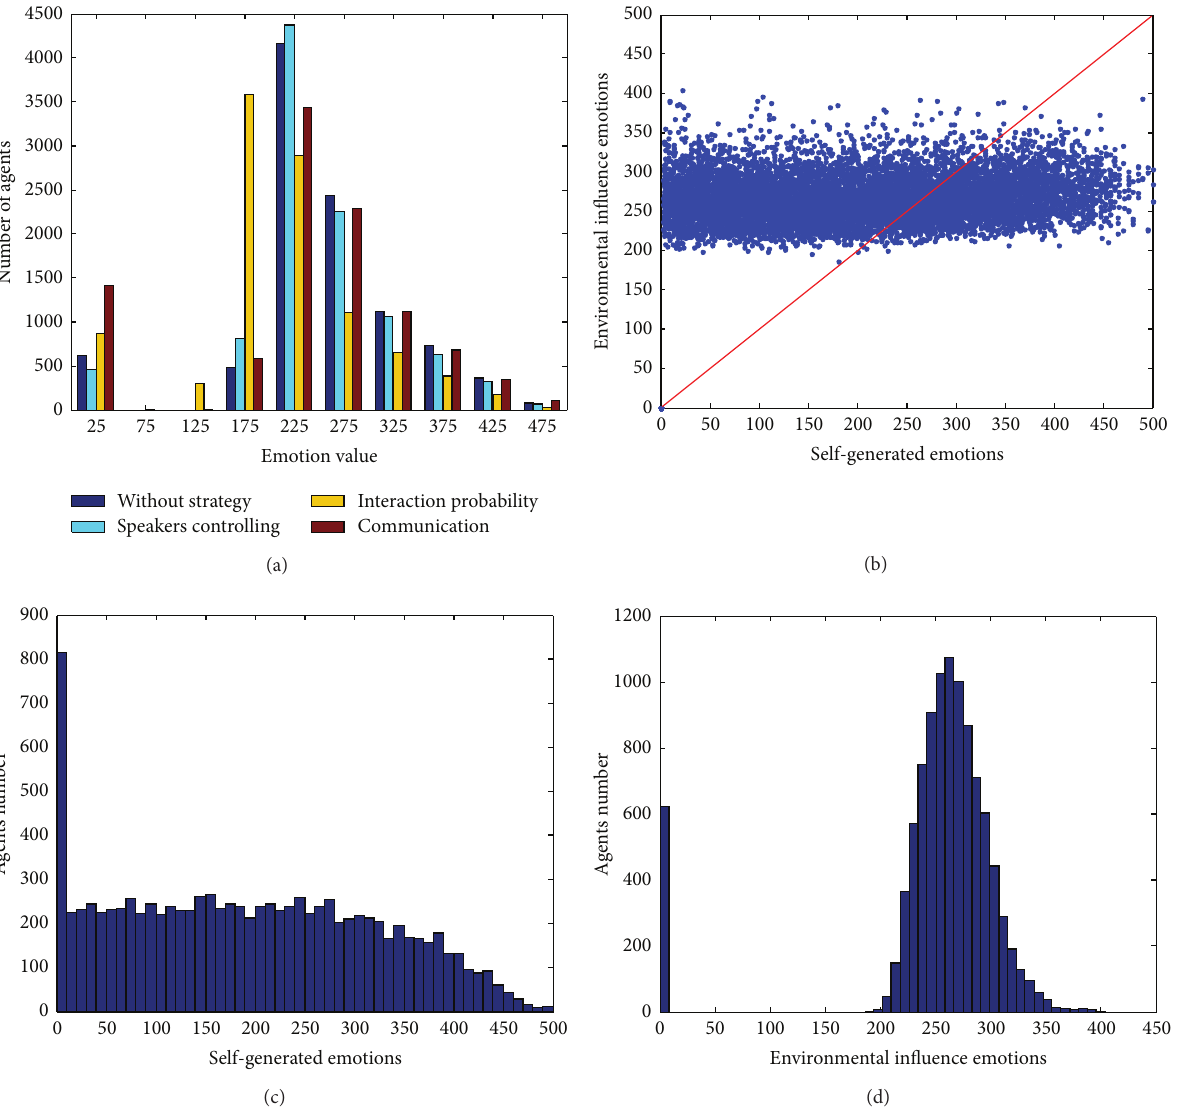
Figure 4: Emotion components distribution at the peak points: (a) emotion distribution of agents in different strategies, (b) scatter diagram of 2-dimension emotion distribution (without strategy), (c) self-generated emotion distribution (without strategy), and (d) environmental emotion distribution (without